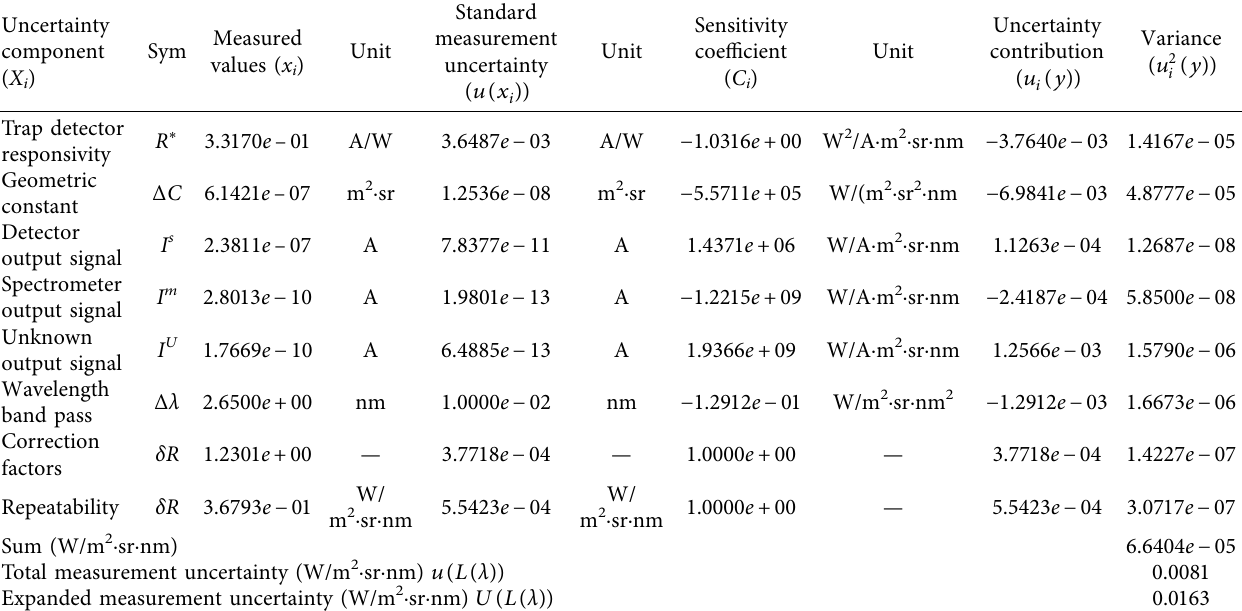
Table 4: k � 2 expanded standard uncertainty budget for 632.8nm in the 11mrad FOV.